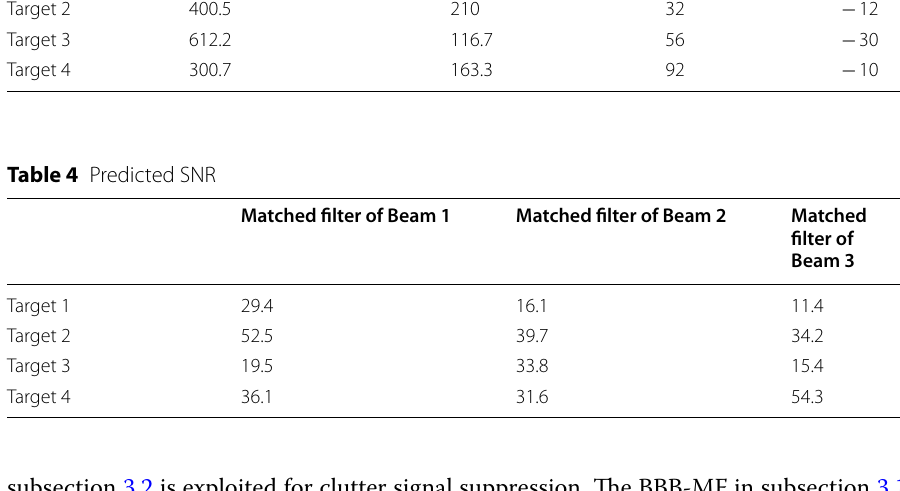
Table 3 Target parameters Bistatic range, m Doppler frequency, Hz AOD, °